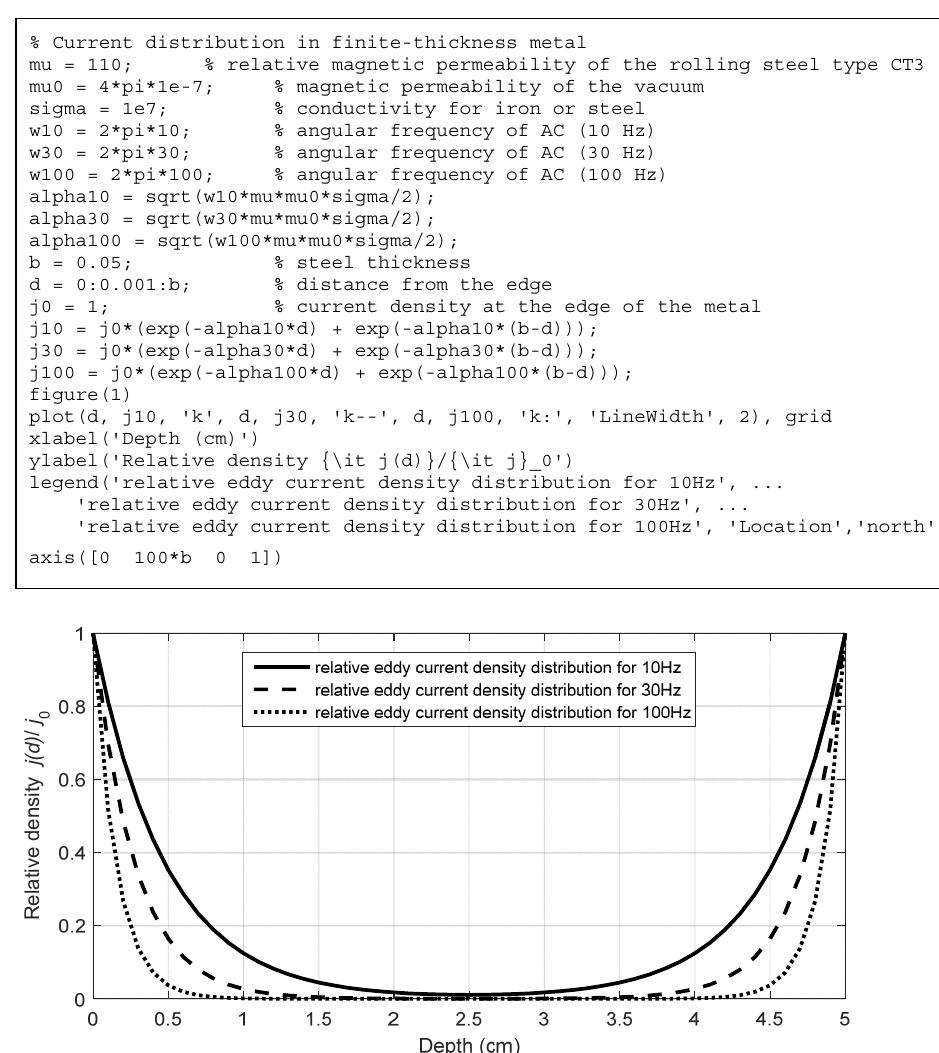
Figure 7. Relative density of eddy currents within a solid steel core of 5 cm thickness for frequencies of 10, 30, and 100 Hz due to the skin effect.